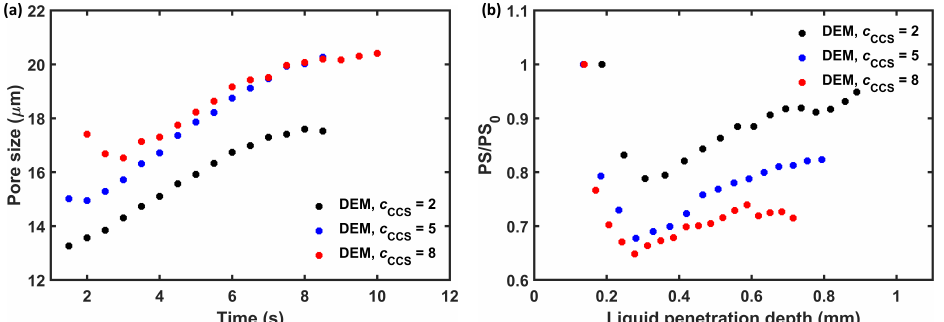
Figure 11. Pore size analysis of the wetted volume for PH101/CCS tablets. ( a ) The average pore size of PH101/CCS tablets at different time points during swelling. ( b ) The pore size ratio (PS/PS 0 ) of the pores placed up to 0.2 mm behind the liquid front as a function of the liquid penetration depth. PS is the pore size at time t, and PS 0 is the pore size at t = 0